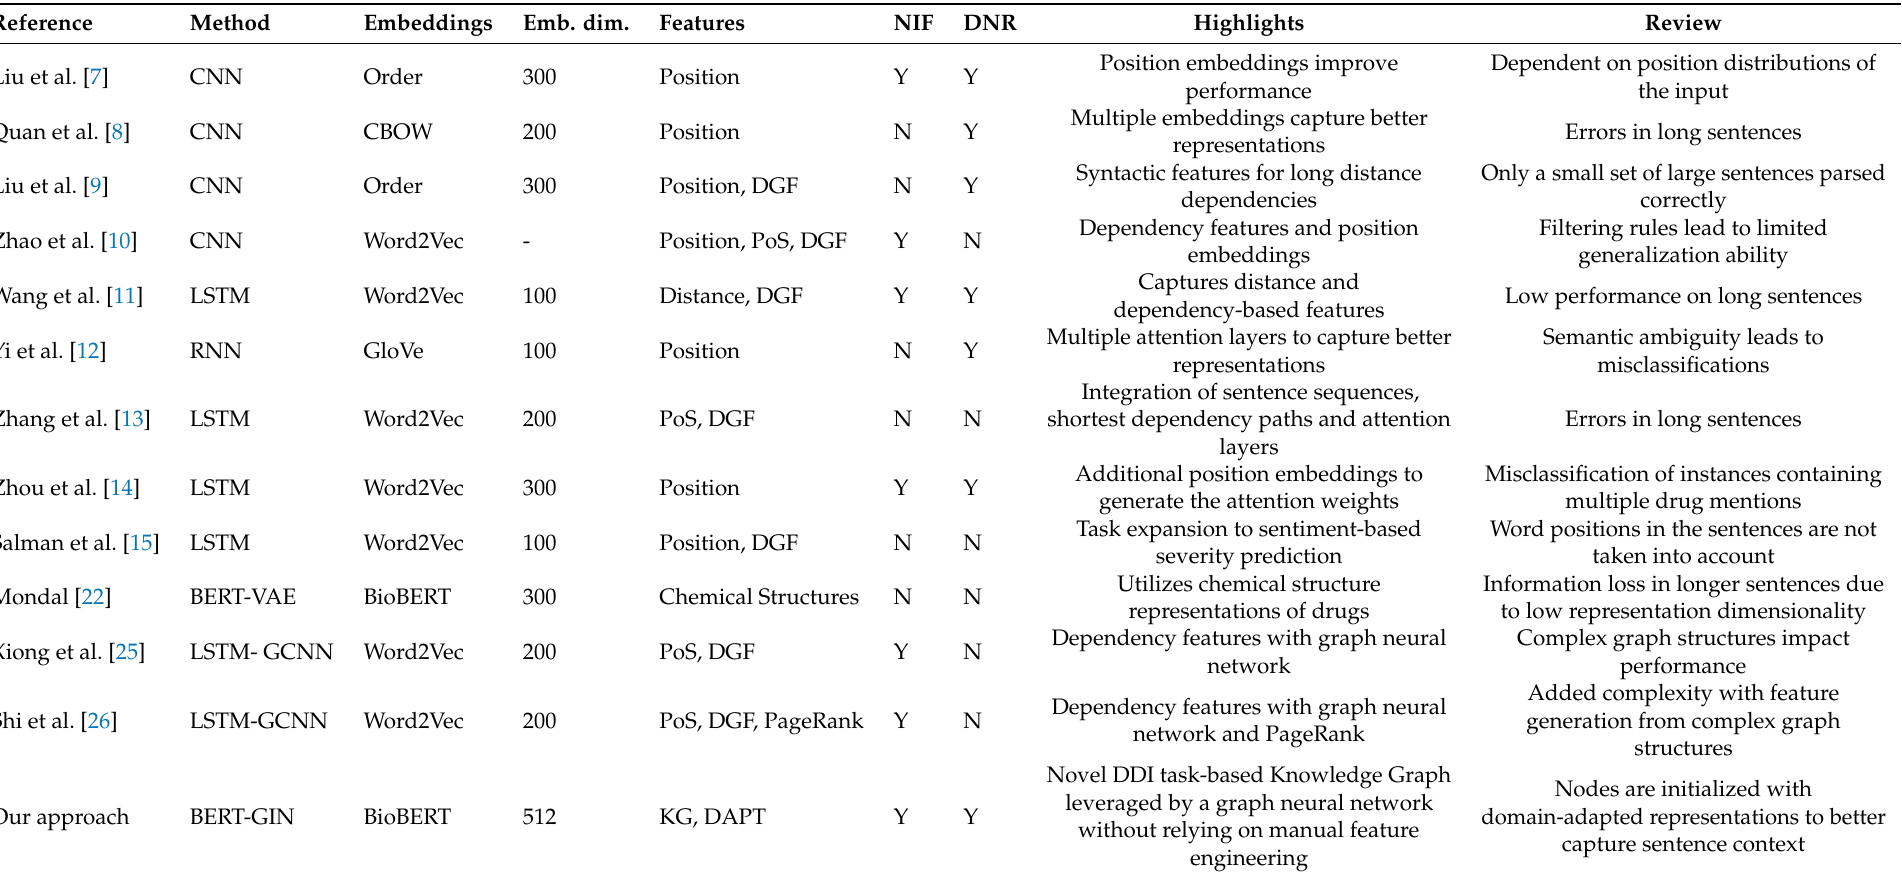
Table A1. Comparative analysis of related studies and our proposed approach. NIF and DNR denote Negative Instance Filtering and Drug Name Replacement, respectively. Values that are not reported in the published work are denoted with ‘-’. DGF denotes Dependency Graph Features. Y and N denote Yes and No,